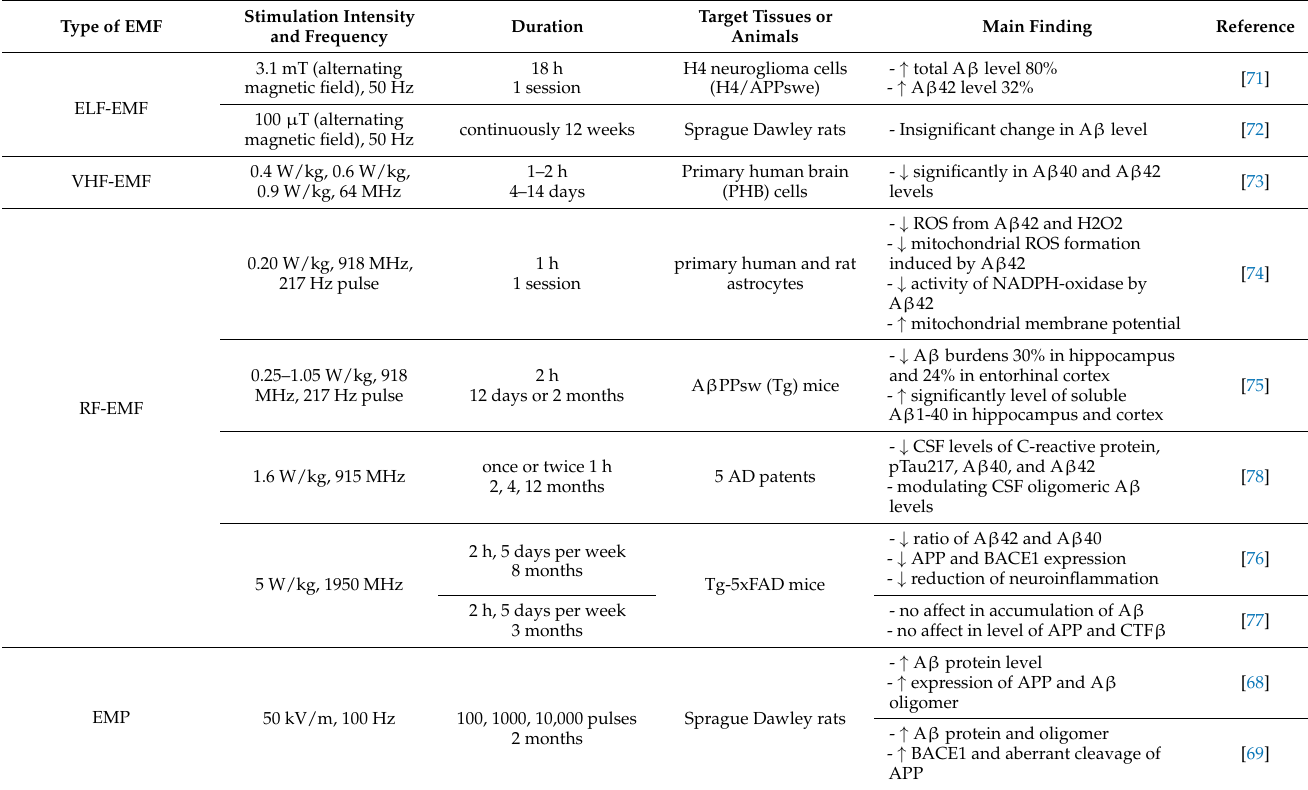
Table 3. A summary of EMF stimulation on A β and tau